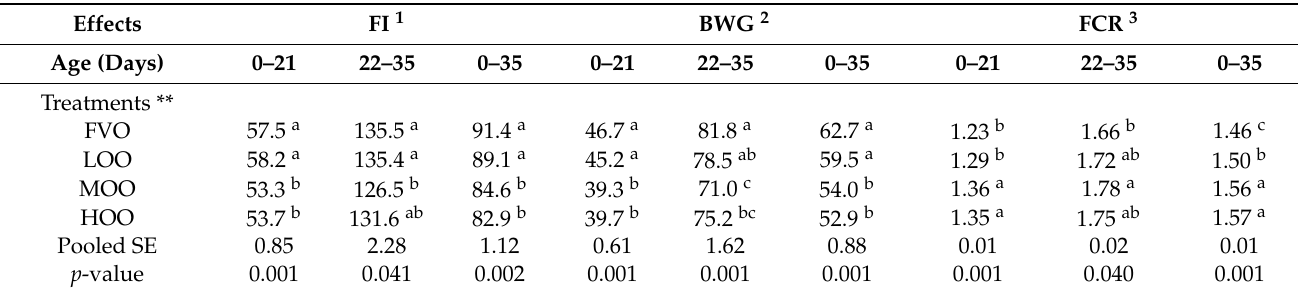
Table 1. Influence of various oxidation levels of vegetable oil on broiler’s growth performance during starter, grower and overall period *.